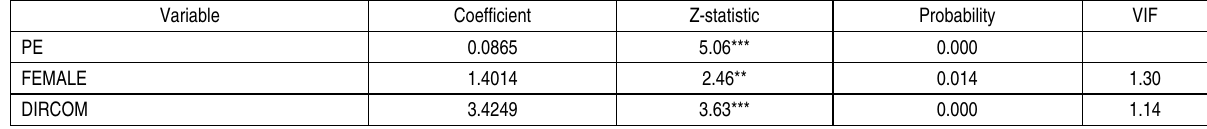
Table 4. GMM regression